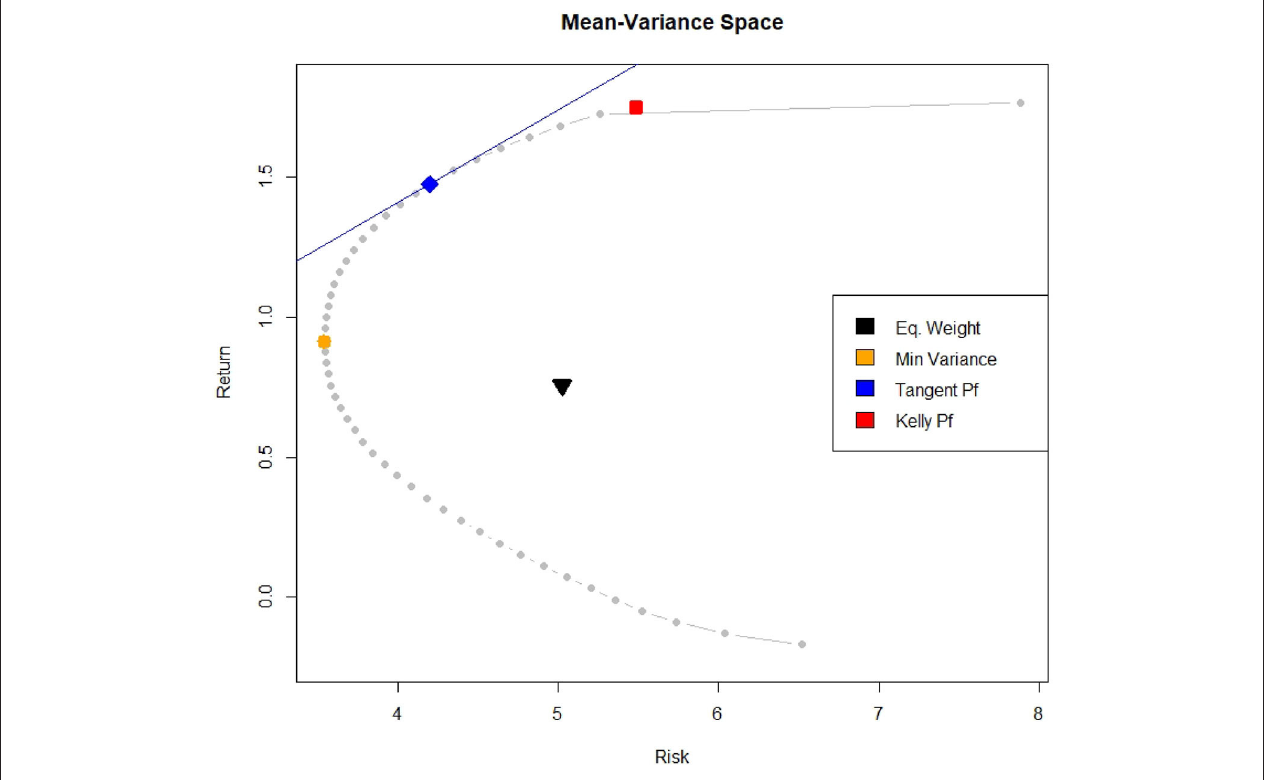
FIGURE 4 | Efficient Frontier and optimal portfolios (monthly